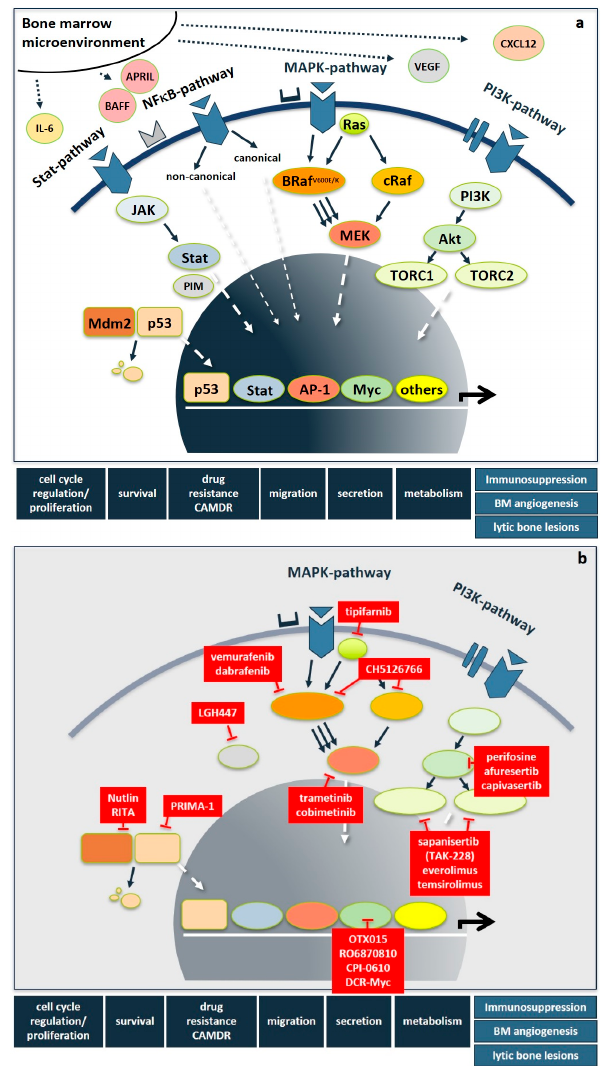
Figure 1. Deregulated signaling cascades and pathway-directed therapies in multiple myeloma. ( a ) Signaling pathways in multiple myeloma. In multiple myeloma, genetic abnormalities and bone marrow microenvironment-driven deregulations, such as increased levels of IL-6, IGF1, HGF, VEGF, CXCL12, TNF α , BAFF, APRIL, and CCL3 derived from stromal, bone, and immune cells result in the activation of multiple signaling pathways, most prominently including the RAS/RAF/MEK/ERK-, PI3K/AKT-, NF κ B-, and STAT-pathway but also the WNT-, Hedgehog-, and TNF α -pathway. They trigger tumor cell proliferation, survival, drug resistance, migration, secretion of humoral factors but also promote immunoparesis, bone marrow angiogenesis, and bone disease. ( b ) Pathway- directed therapies. Abbreviations: Bone marrow (BM), cell adhesion-mediated drug resistance (CAMDR), interleukin-6 (IL-6), B-cell activating factor (BAFF), A proliferation inducing ligand (APRIL) vascular endothelial growth factor (VEGF), C-X-C motif chemokine 12 (CXCL12), Signal transducer and activator of transcription (STAT), nuclear factor kappa B (NF κ B), phosphoinositide 3-kinase (PI3K), Janus kinase (JAK), Mouse double minute 2 homolog (Mdm2), CREB-regulated transcription coactivator 1 (TORC1), CREB-regulated transcription coactivator 1 (TORC2), protein kinase B (AKT), RAS-kinase (RAS), B-RAF-kinase (BRAF), C-RAF-kinase (cRAF), mitogen activated protein kinase (MAPK), mitogen activated protein kinase kinase (MEK), proviral insertion site of Moloney murine leukemia virus kinase (PIM), Activator protein-1